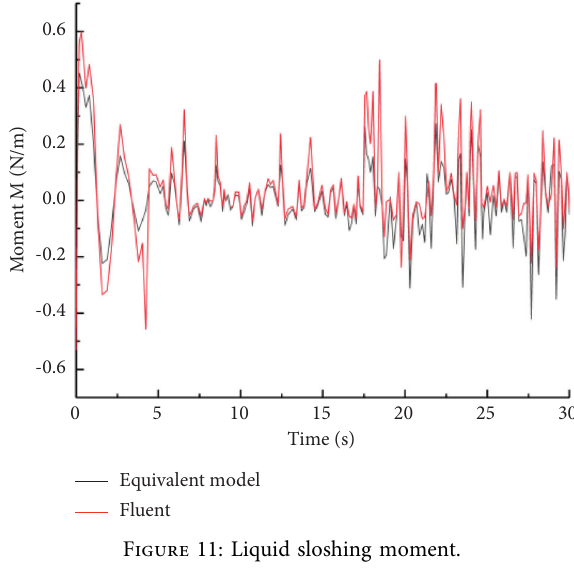
Figure 11: Liquid sloshing moment.